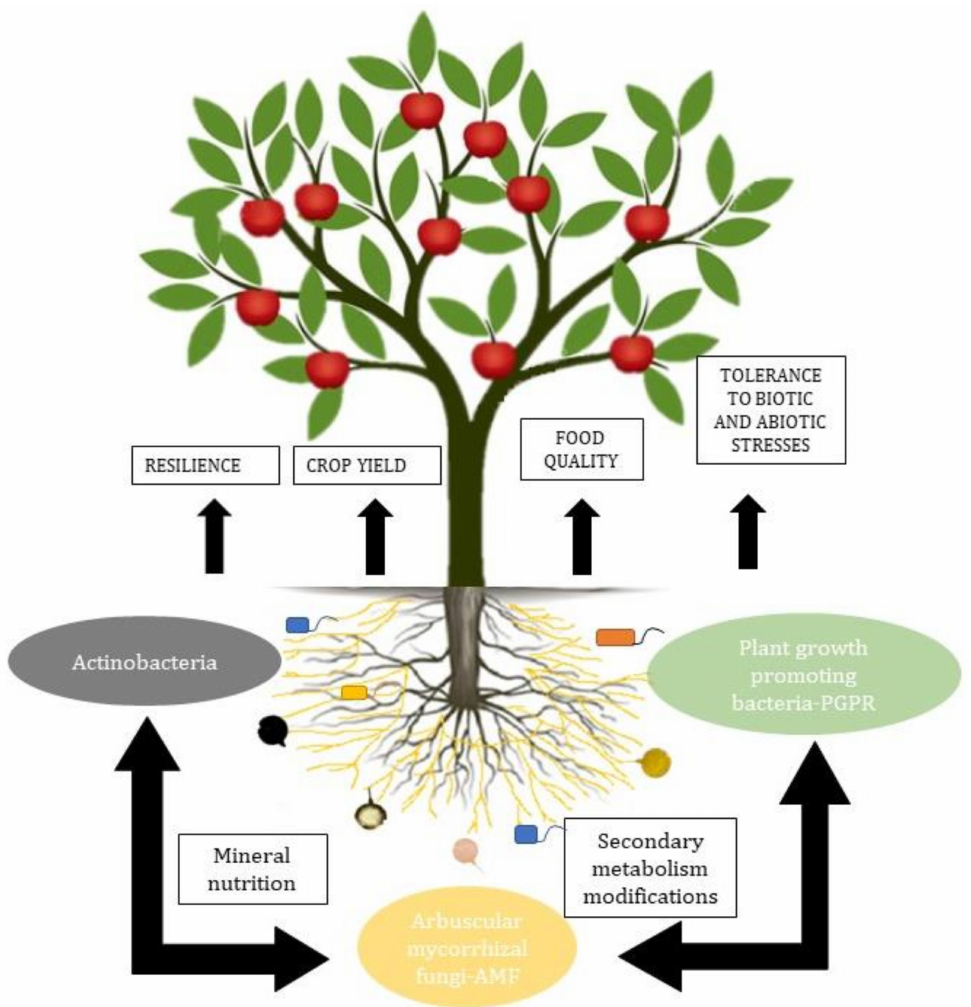
Figure 1. The ecosystem functions of microbial consortia of Actinobacteria, plant growth-promoting rhizobacteria (PGPR), and arbuscular mycorrhizal fungi (AMF) in sustainable